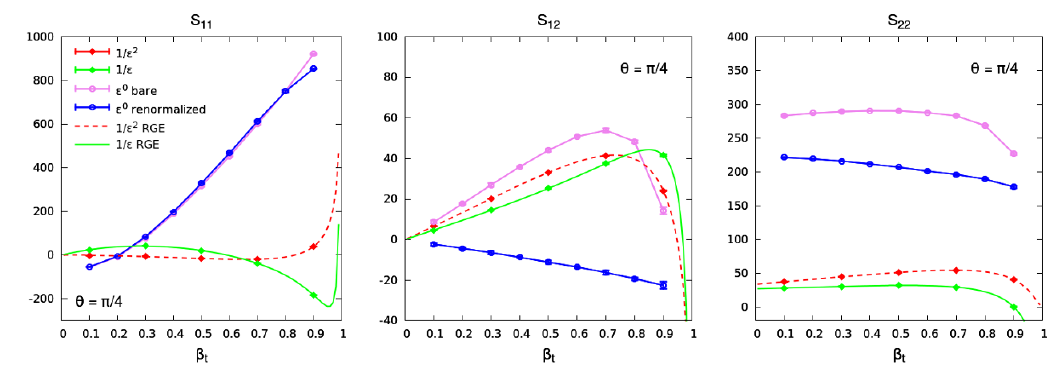
Figure 16 . Real part of the NNLO soft function in the q (cid:22) q channel. The (cid:12)gure shows three independent entries of the 2 (cid:2) 2 matrix determined for the (cid:12)xed values of (cid:18) = (cid:25)= 4 and L ? = 0. All the points come from our direct calculation at di(cid:11)erent orders in (cid:15) expansion. The two results at order (cid:15) 0 correspond to the (cid:12)nite part of the NNLO soft function before and after renormalization. The RG predictions for the pole part are shown as red (dashed) and green (solid) lines. The points for order (cid:15) 0 are connected by straight lines for better